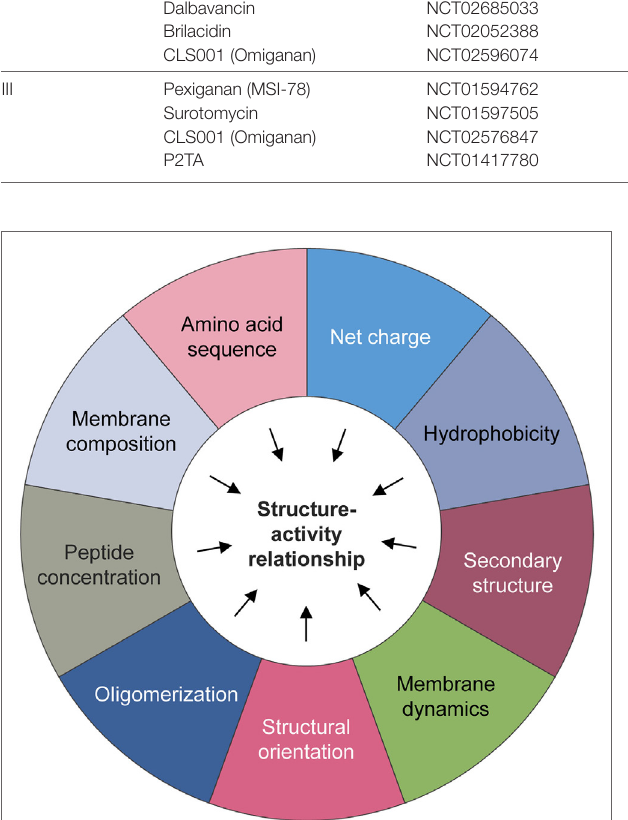
FiGURe 5 | Physicochemical considerations that may impact structure– activity. A number of biochemical factors need to be considered when predicting the anticancer activity of natural or synthetic antimicrobial peptides, including but not limited to the amino acid sequence, net charge, hydrophobicity, structural folding (i.e., secondary structure, dynamics, and orientation) in membranes, oligomerization, peptide concentration, and membrane composition.